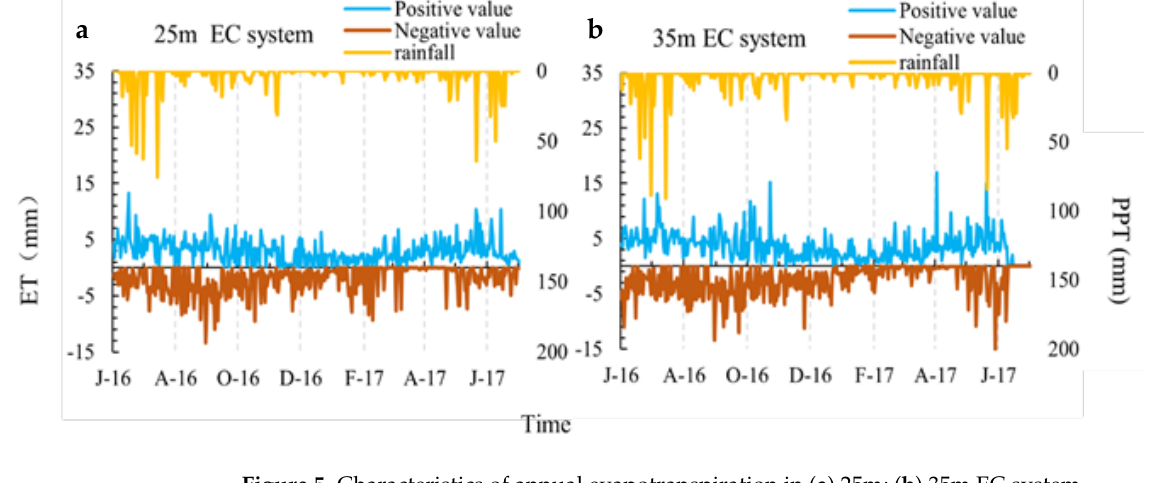
Figure 5. Characteristics of annual evapotranspiration in ( a ) 25m; ( b ) 35m EC system.